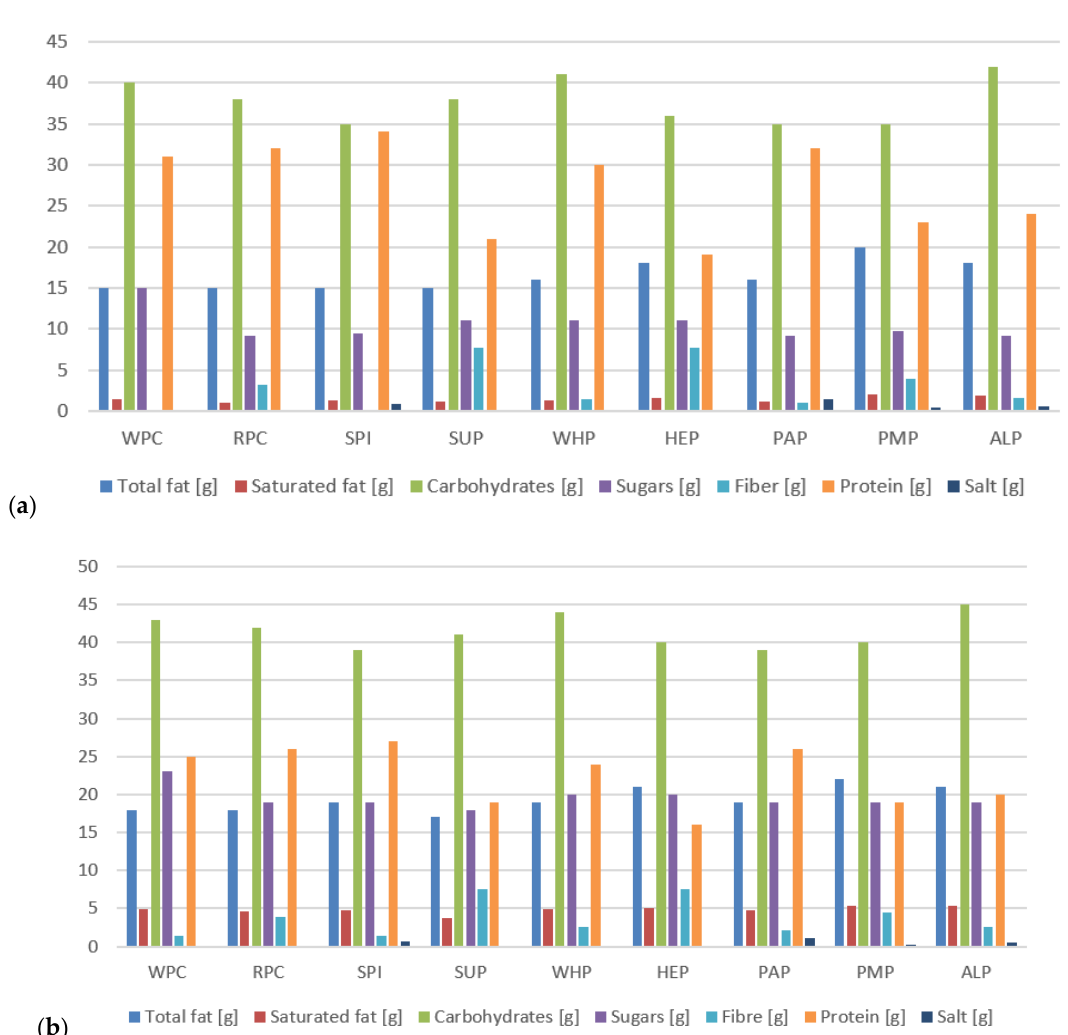
Figure 7. ( a ) Nutritional value of high-protein bars without chocolate coating; ( b ) With chocolate Figure7. ( a ) Nutritionalvalue of high-protein bars withoutchocolate coating; ( b ) Withchocolate coating.